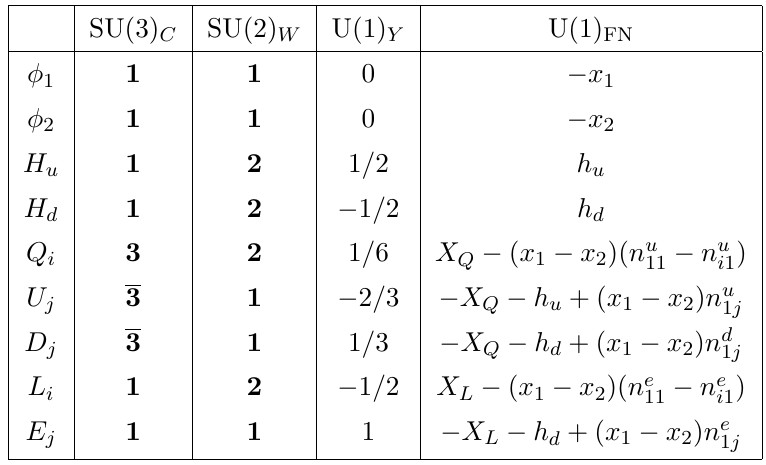
is the U(1) FN charge of Q 1 , 1